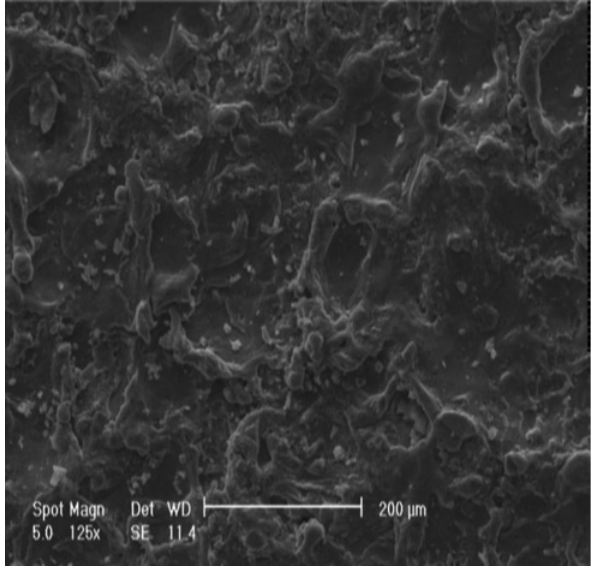
Figure 13: SEM micrograph of the machined surface of 2024